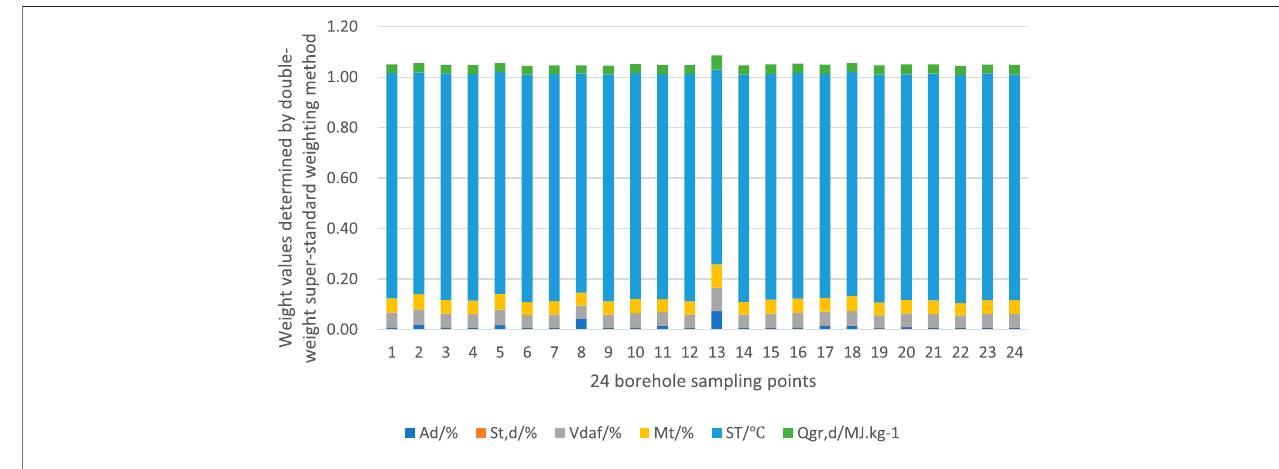
FIGURE 6 | Weight values determined by double-weight super-standard weighting method.